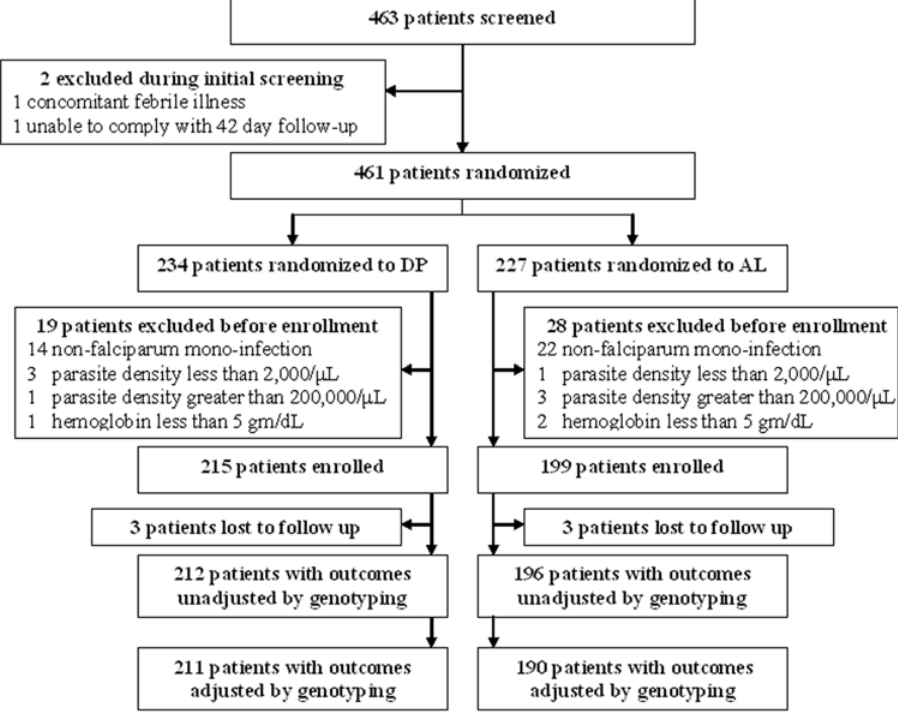
Figure 1. Trial profile comparing antimalarial treatment regimens. AL=artemether-lumefantrine; DP=dihydroartemisinin-piperaquine.